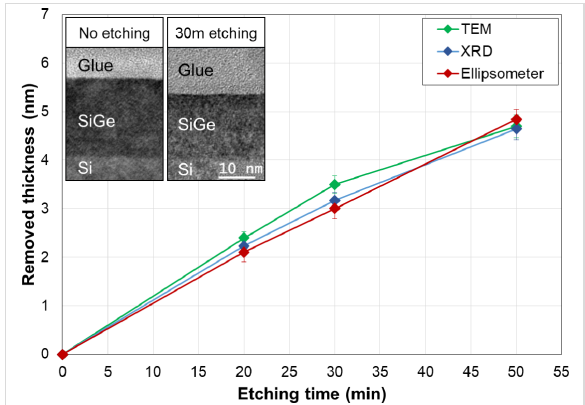
Figure 1: Removed SiGe thickness measured by different methods (TEM, XRD and ellipsometry) as a function of the etching time. Ge content: 27 atom %. Inset: TEM cross-section micrographs of refer- ence and the sample etched for 30 min. This figure illustrates the agreement between the three chosen techniques.